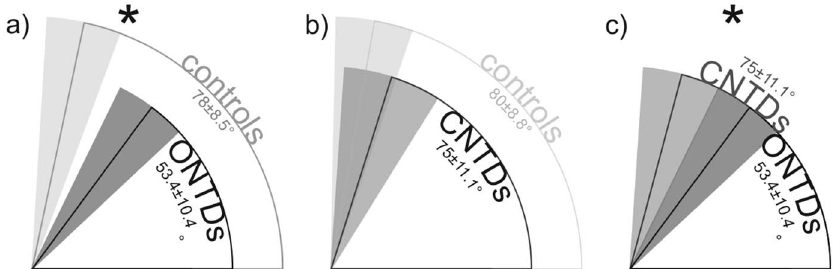
Figure 7. Comparisons of the CSA in ONTDs, CNTDs and the respective control groups. Sector outlines represent mean values and gray sectors represent standard deviations of the CSA in fetuses with ONTDs (a, c), with CNTDs (b, c) and their respective age matched control fetuses with normal CNS development (a, b). Asterisks indicate significant differences between ONTDs and control fetuses with normal CNS and between ONTDs and CNTDs (p ,